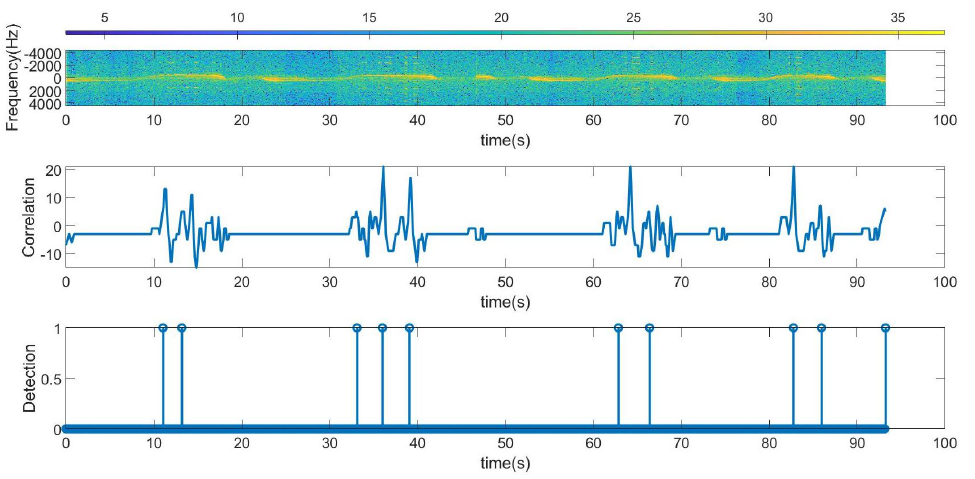
Figure 18. Measurement for a moving scooter sending Barker codes with length 7: scooter Doppler frequency estimation and detected frequency for bit 1.